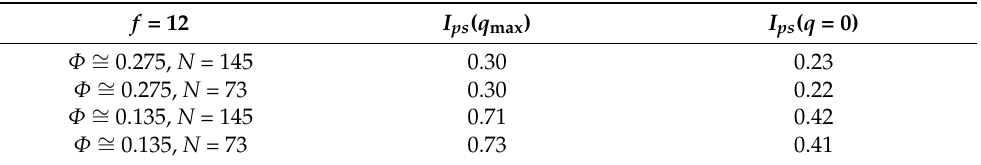
Table 3. Scattering functions at q = 0 and q max obtained assuming the same optical contrast factors for A and B units with respect to the solvent corresponding to the f = 12-star molecules without segregation and with different densities and number of units.